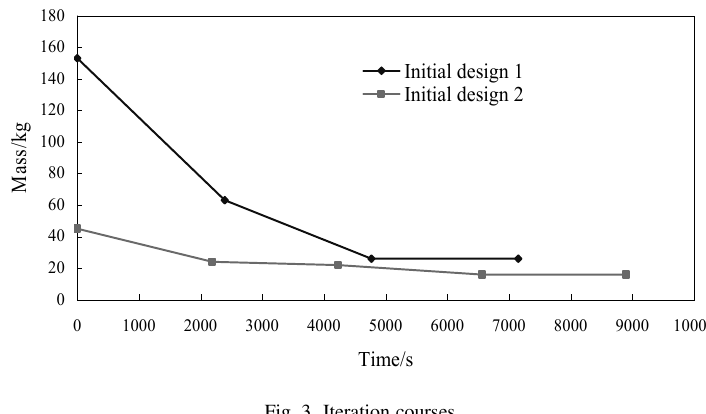
Fig. 3. Iteration